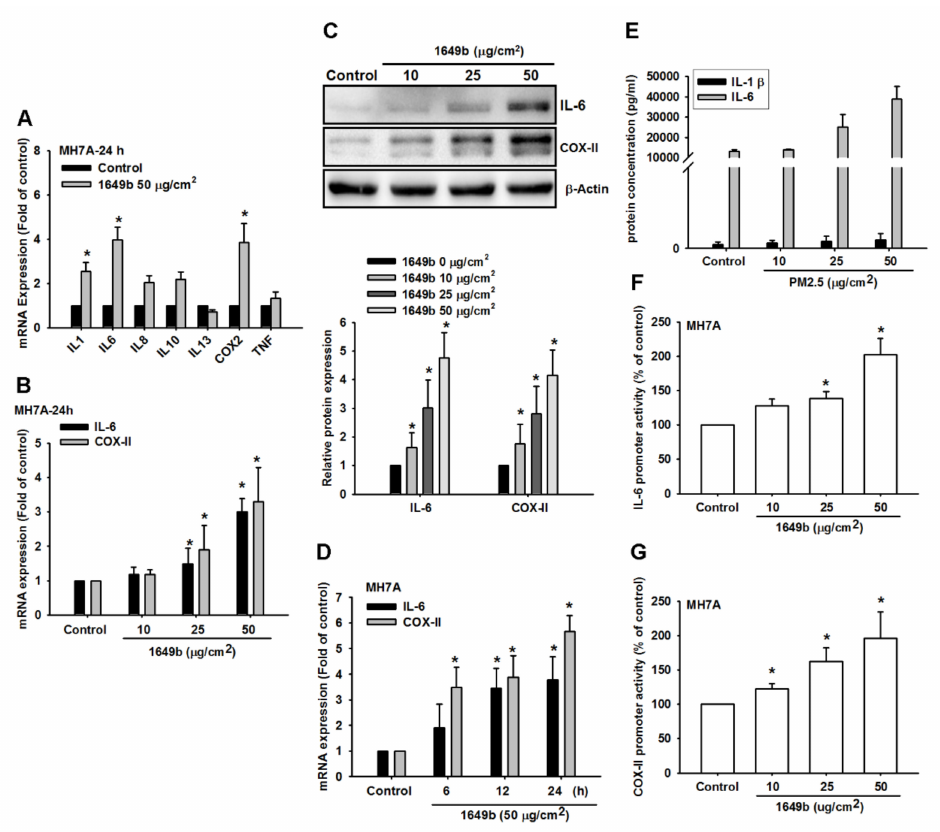
Figure 1. Concentration- and time-dependent increase in IL-6 production by particulate matter (PMs). ( A ) Human rheumatoid arthritis fibroblast-like synoviocytes (RA-FLS) were incubated with PMs (50 µ g / cm 2 ) for 24 h. The mRNA expression of inflammatory cytokines were examined using qPCR ( n = 4); ( B ) RA-FLS were incubated with various concentrations of PMs for 24 h. The mRNA expression of IL-6 and COX-2 were examined using qPCR ( n = 4); ( C ) RA-FLS were incubated with various concentrations of PMs for 24 h. The protein expression of IL-6 and COX-2 were examined using western blot ( n = 4); ( D ) RA-FLS were incubated with PMs (50 µ g / cm 2 ) for 6, 12 or 24 h. The mRNA expression of IL-6 and COX-2 were examined using qPCR ( n = 4); ( E ) RA-FLS were incubated with various concentrations of PMs for 24 h; supernatants and cell lysates were then collected. The IL-6 level in the culture media was measured using a Quantikine ELISA kit ( n = 4); ( F , G ) RA-FLS were incubated with various concentrations of PMs for 24 h. IL-6 and COX-2 luciferase activity was measured and the results were normalized to the β -galactosidase activity. Results are expressed as mean ± SD. * p < 0.05 compared with the control; # p < 0.05 compared with the PM-treated